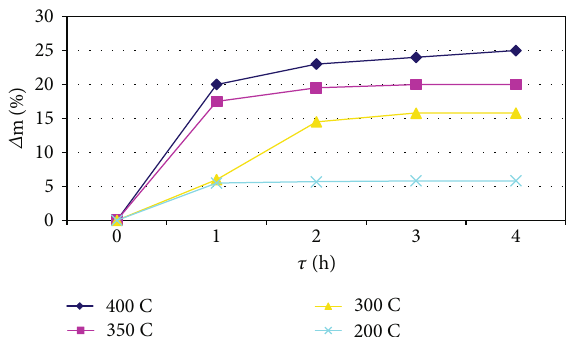
Figure 4: Dependence of the sample weight decrease ( Δ m ) on time ( τ ) at di ff erent temperatures.